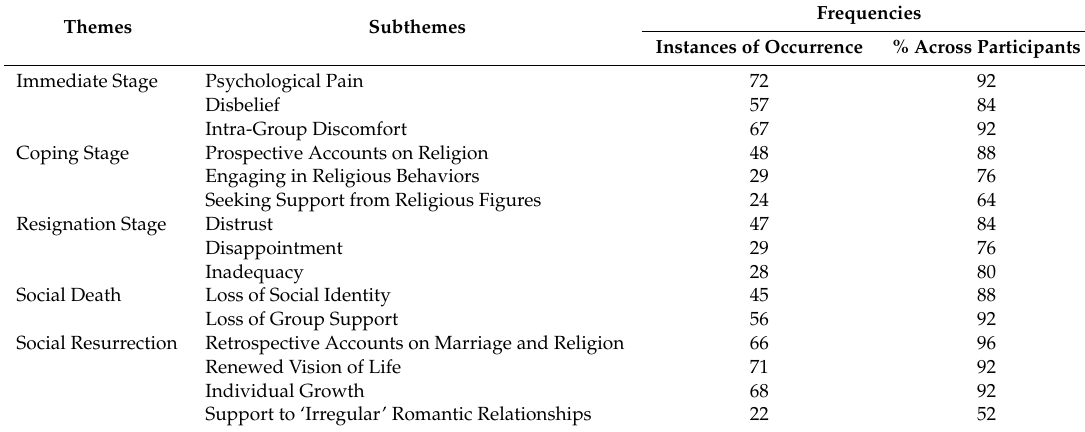
Table 2. Ostracism in Religious